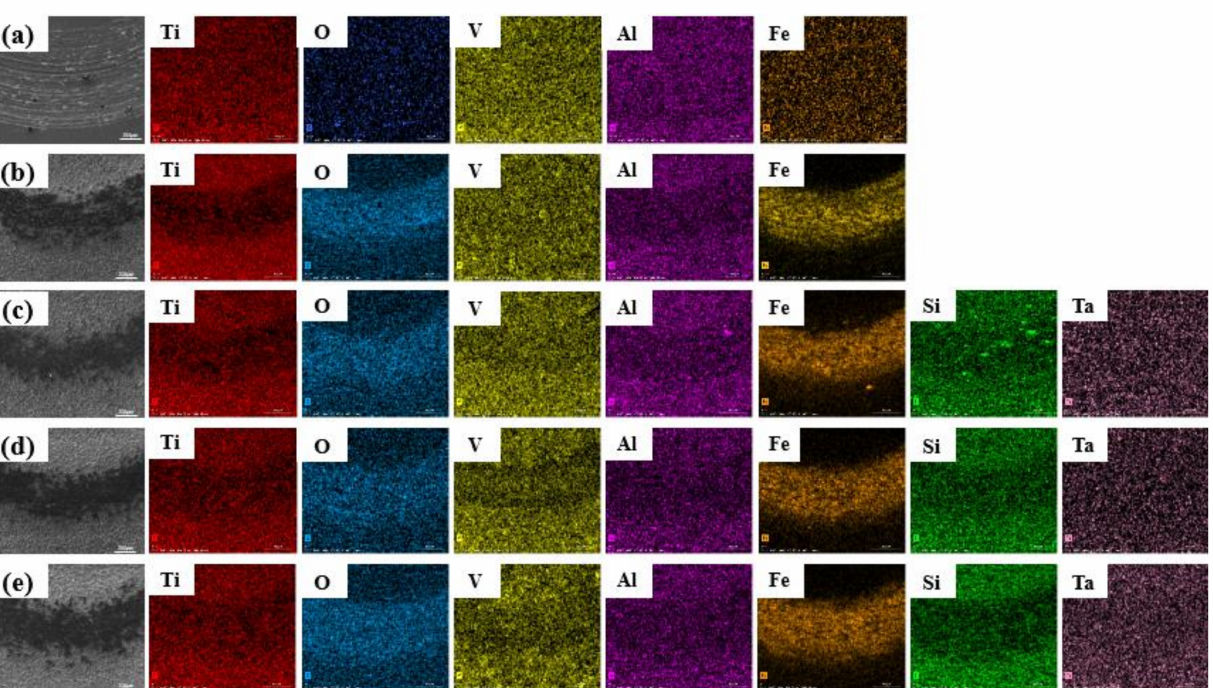
Figure 10. EDS mapping of the wear scar of both the TC4 alloy and the composite MAO coatings with different concentration of Si 3 N 4 /TaC particles: ( a ) TC4; ( b ) 0 g/L; ( c ) 1 g/L Si 3 N 4 + 0.5 g/L TaC;